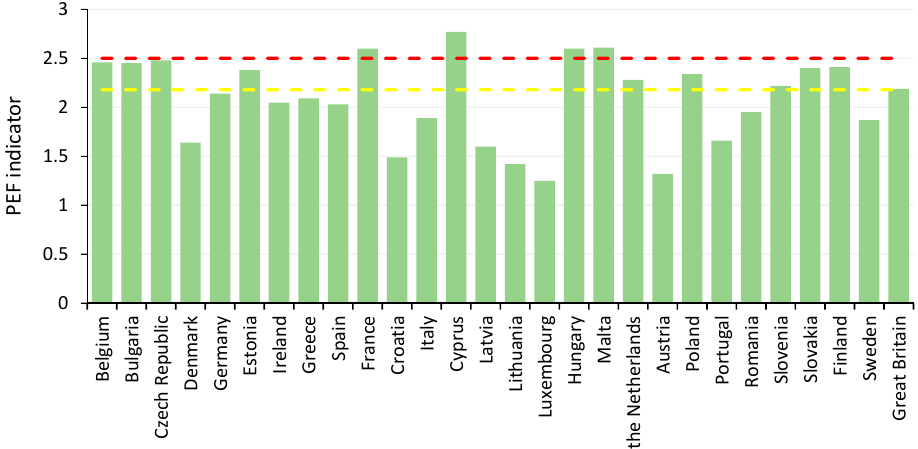
Figure 3. List of PEF indicators calculated for all EU-28 countries: red line—PEF 2012 , yellow line—PEF 2016 .